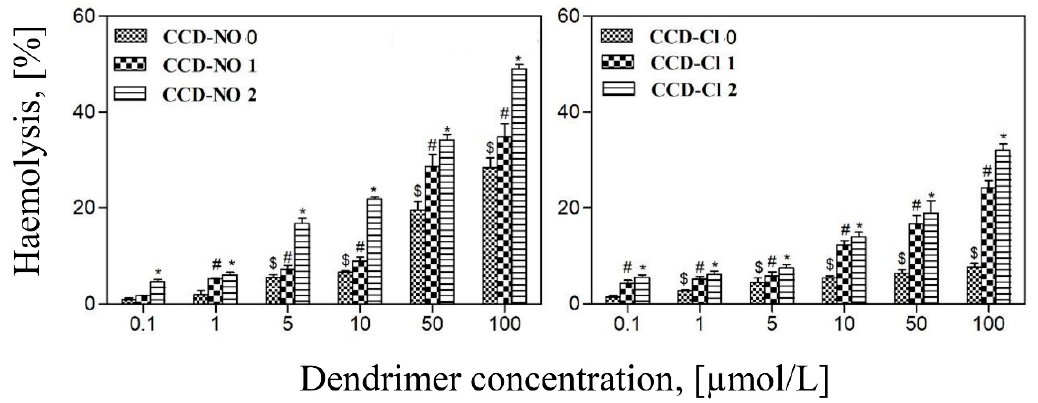
Figure 6. Erythrocyte haemolysis induced by copper metallodendrimers after 24 h of incubation. The concentration range 0.1–100 µmol/L. 2% haematocrit in PBS buffer, pH 7.4, 22°C. Results are mean ± SD, n = 6.